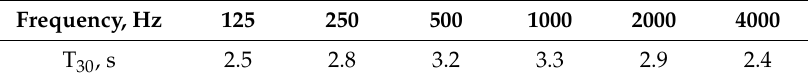
Table 2. Reverberation time in octave band measured in the environment test.